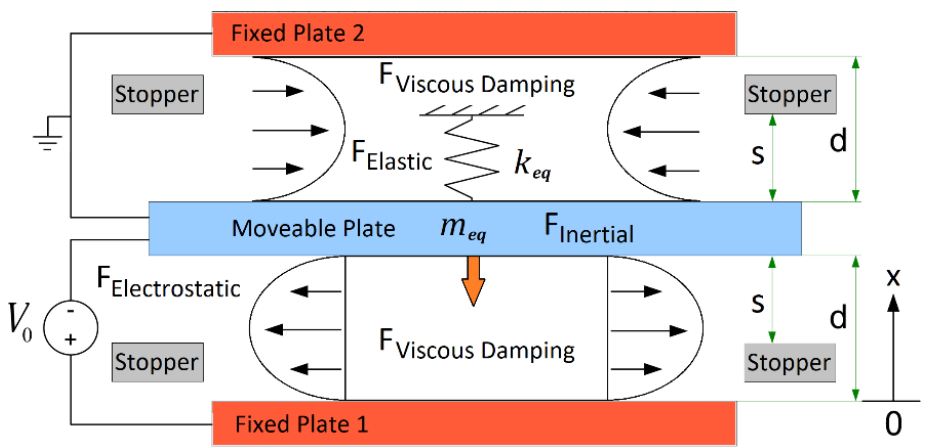
Figure 4. Lumped-parameter modeling of the AUC as a parallel-plate capacitor with squeeze-film damping. m eq is the moveable plate’s equivalent mass, k eq is the serpentine flexures’ equivalent spring constant, x is the position of the moveable plate, d is the initial (nominal) gap, s is the stroke extending to the stoppers, and V 0 is the actuation